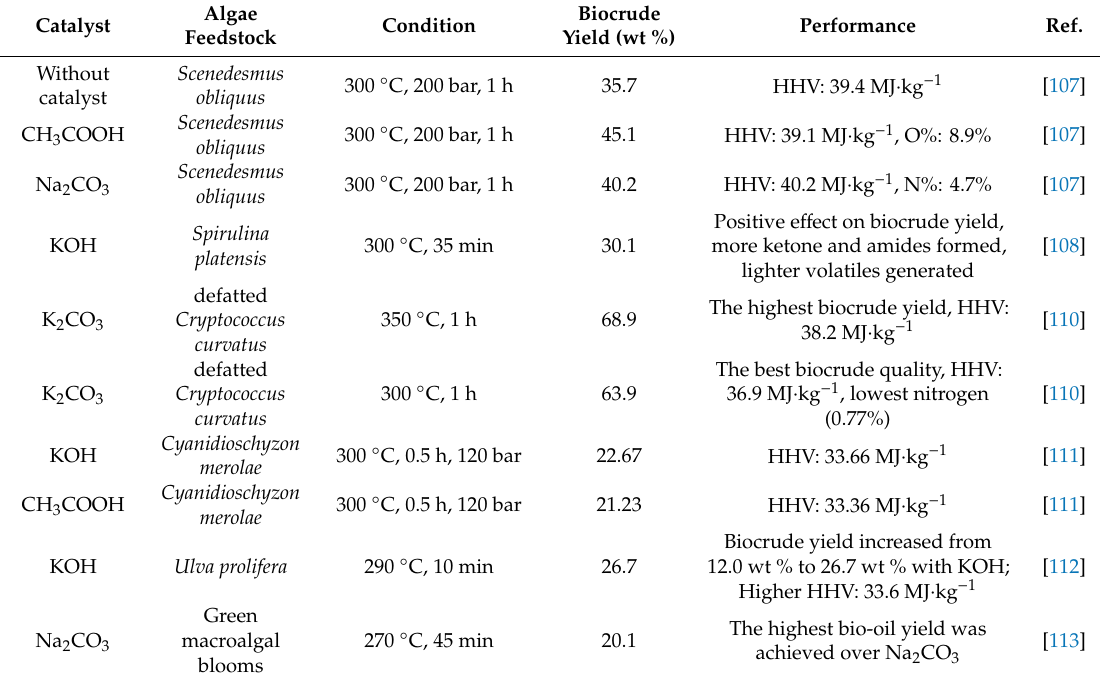
Table 4. Catalytic HTL of algae with homogeneous